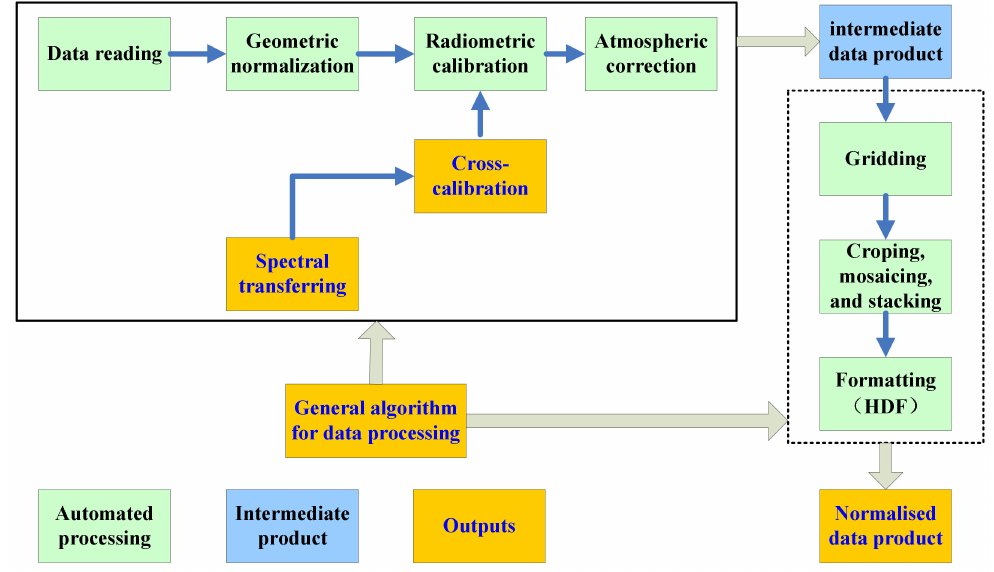
Figure 2. The illustration of the major idea of the proposed framework for the Chinese data